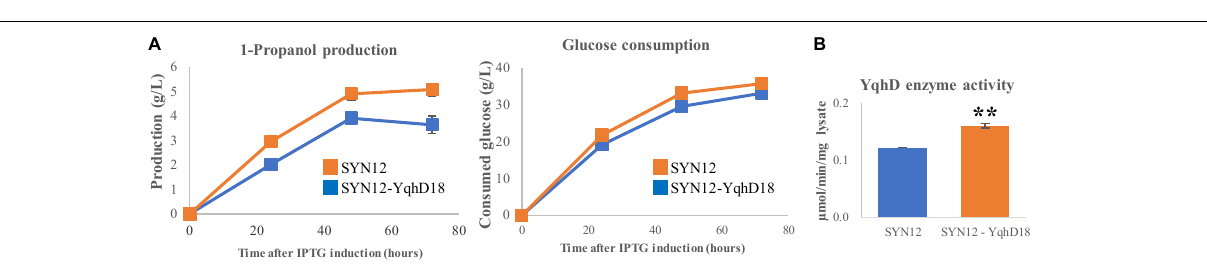
FIGURE 3 | Effect of avtA deletion or tpiA overexpression. (A) 1-Propanol production. (B) Intracellular 2-ketobutyrate and 2-aminobutyrate. Samples were taken after 24 h of fermentation. Metabolite intensities shown in the y -axis were normalized to an internal standard. Asterisks indicate significant difference from the strain (* p < 0.05, ** p < 0.01). The error bars indicate standard deviations obtained from three replicate fermentations.